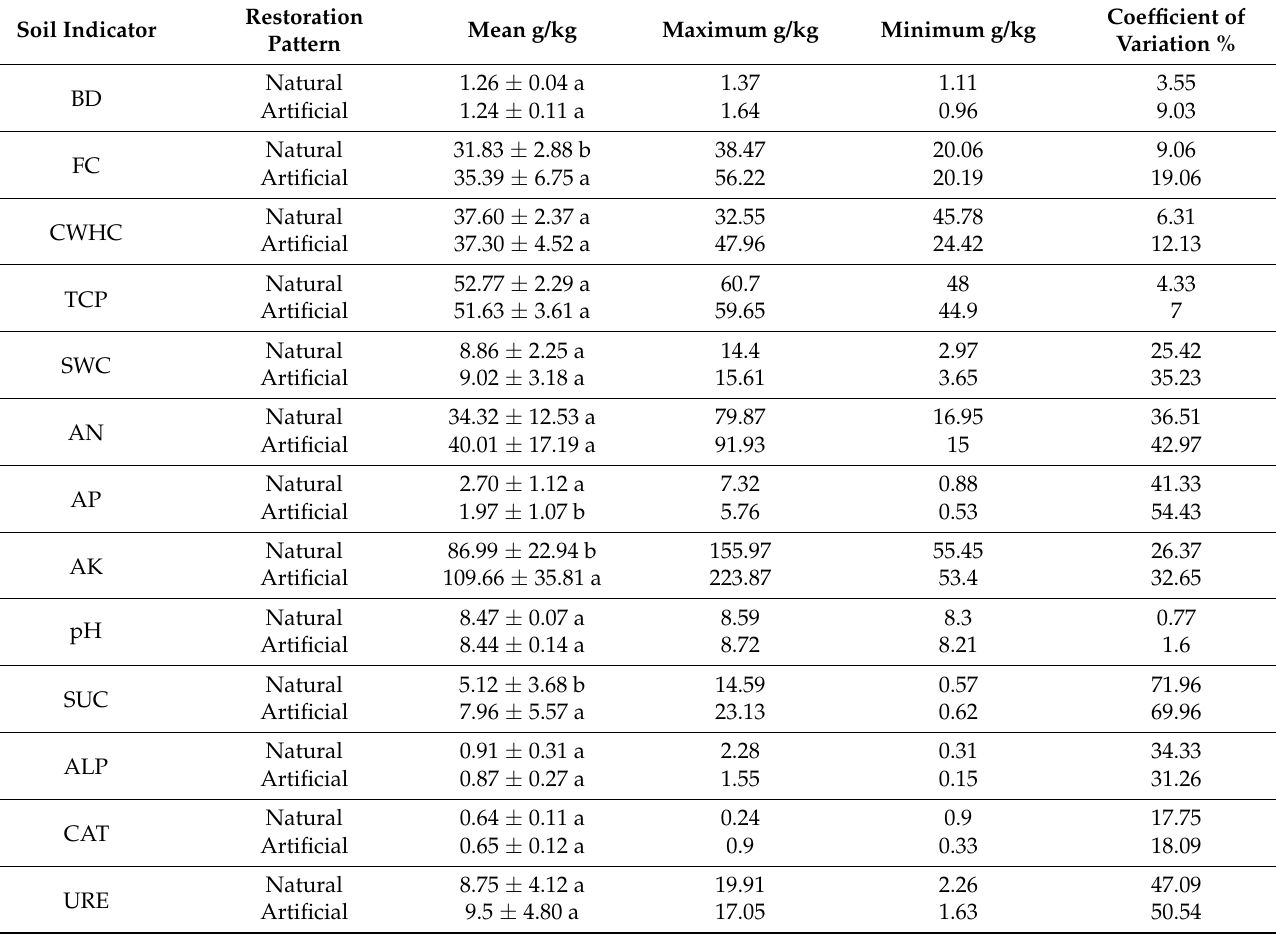
Table 2. The statistical features of soil indicators under different restoration